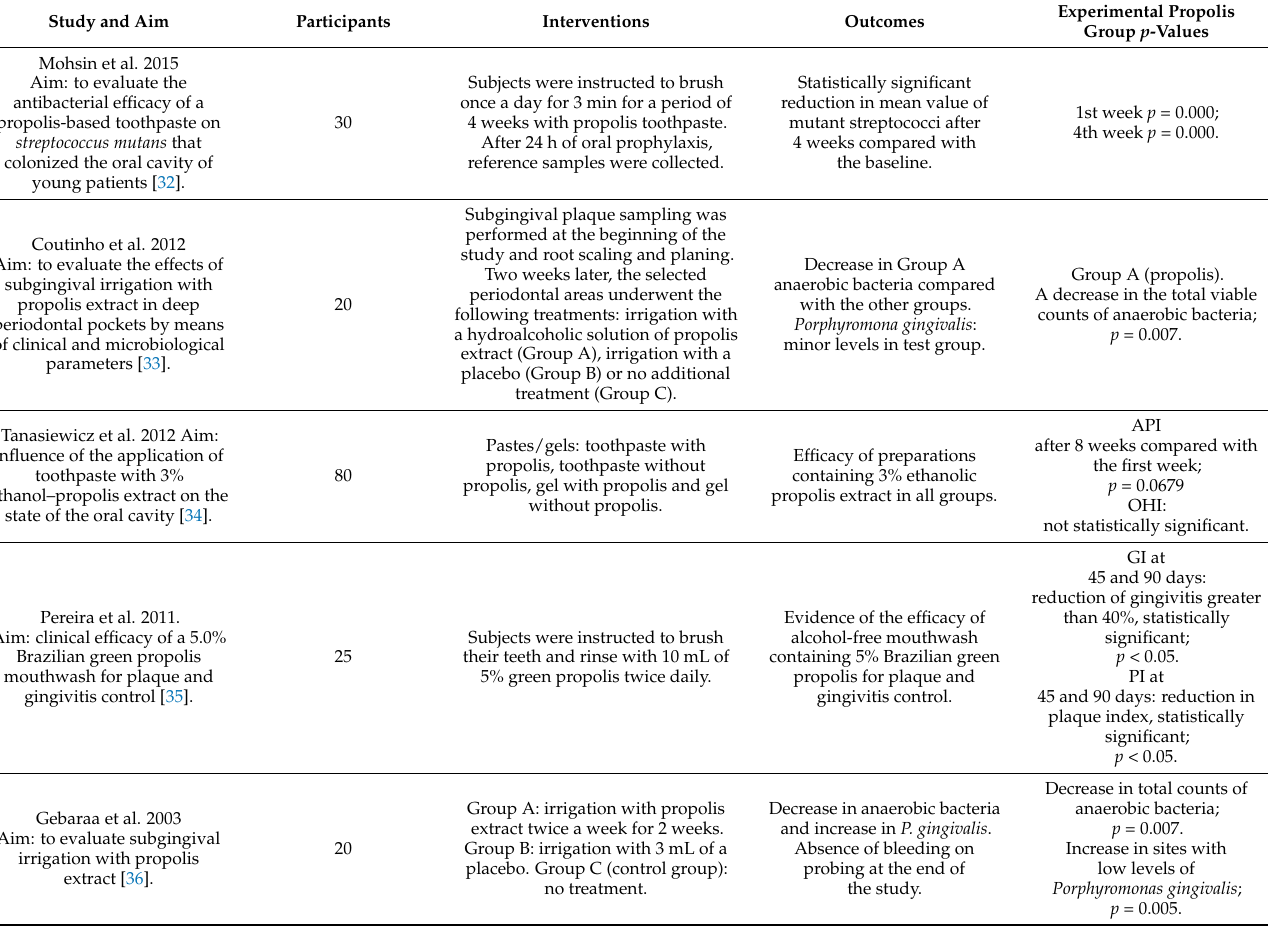
Table 3. Characteristics of Non-Randomized